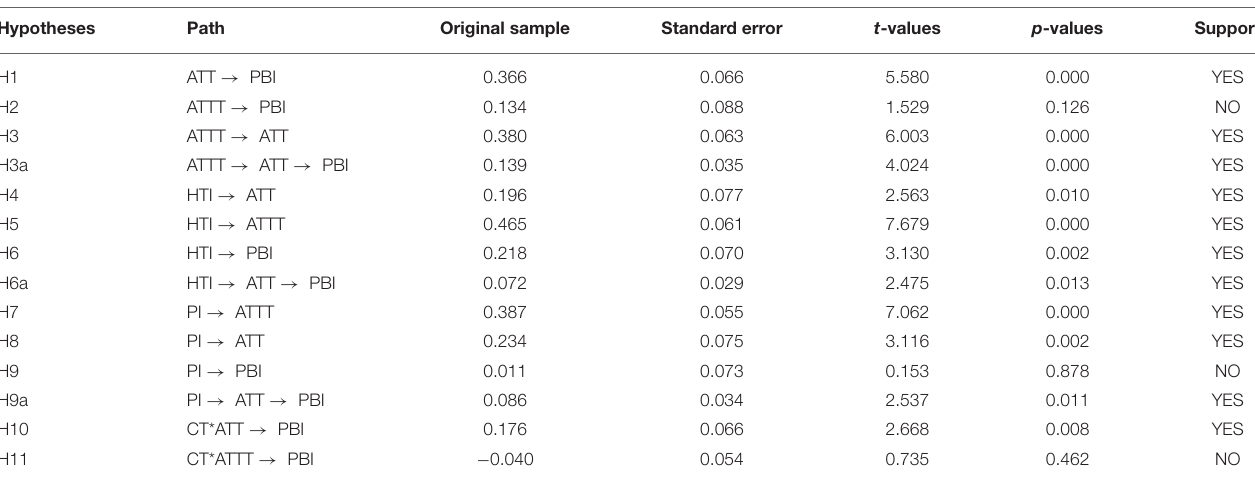
TABLE 4 | Results of hypotheses